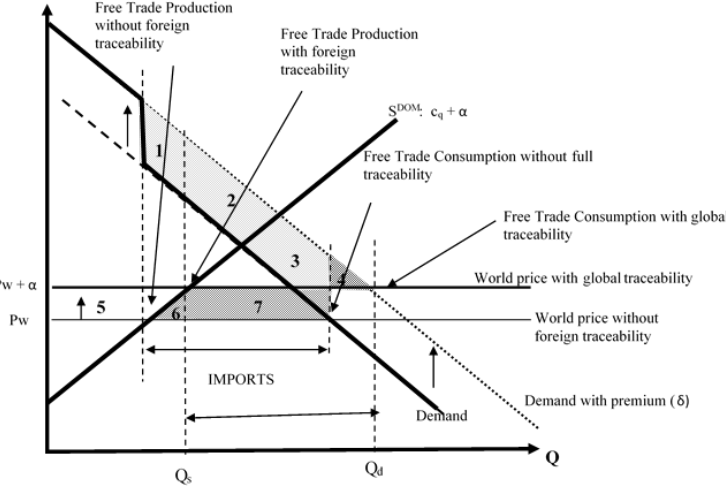
Figure 4. Free trade with global traceability ω = 1.